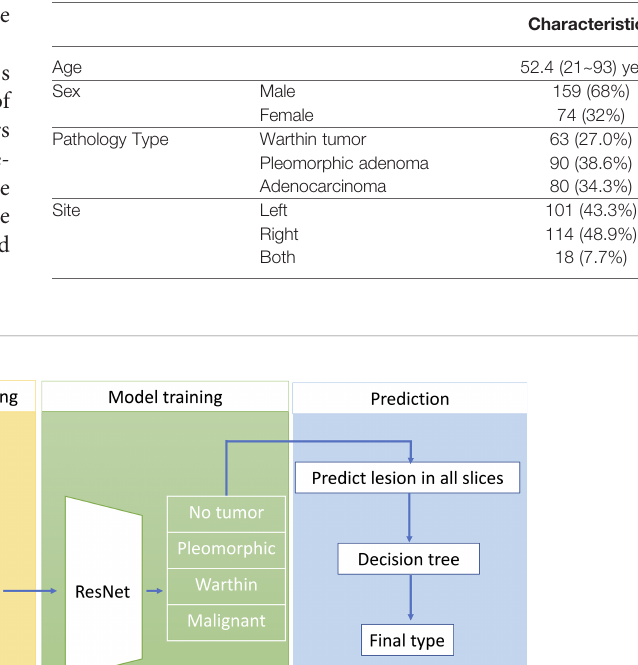
TABLE 1 | Patient